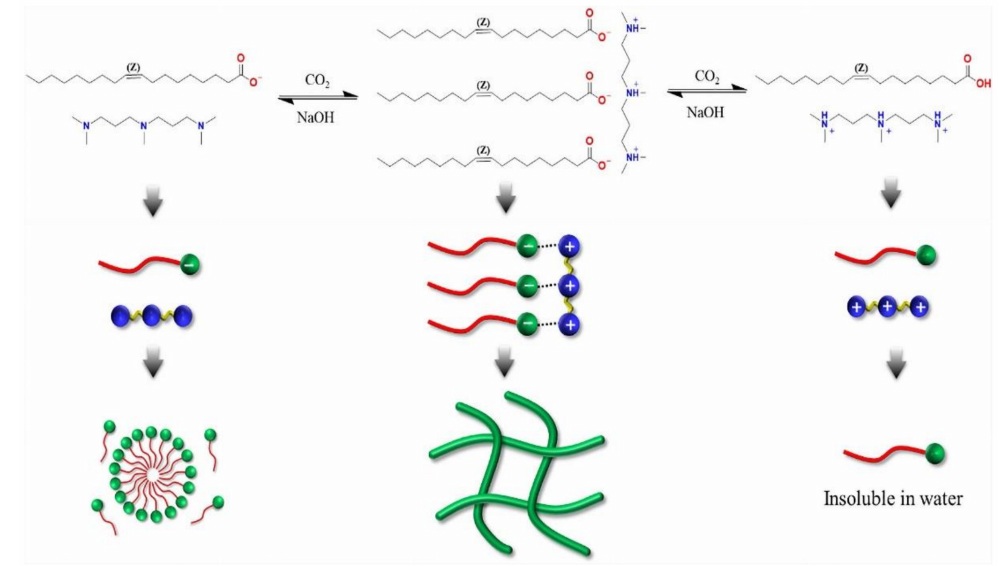
Figure 4. The system’s self-assembly technique, triggered by CO 2 , is schematically illustrated [102]. Another same kind of study by Zhang and his co-authors [88] created pseudogemini VES solution of anionic surfactant sodium dodecyl sulfate (SDS) and N , N , N , N -tetramethyl- 1,3-propanediamine (TMPDA) in the ratio of 2:1. CO 2 /N 2 altered the rheological behavior between non-Newtonian and Newtonian, as illustrated in Figure 5. The viscosity of a 250 mM SDS-TMPDA aqueous phase is low; however, the fluid viscosity improves after bubbling TMPDA solution with CO 2 .